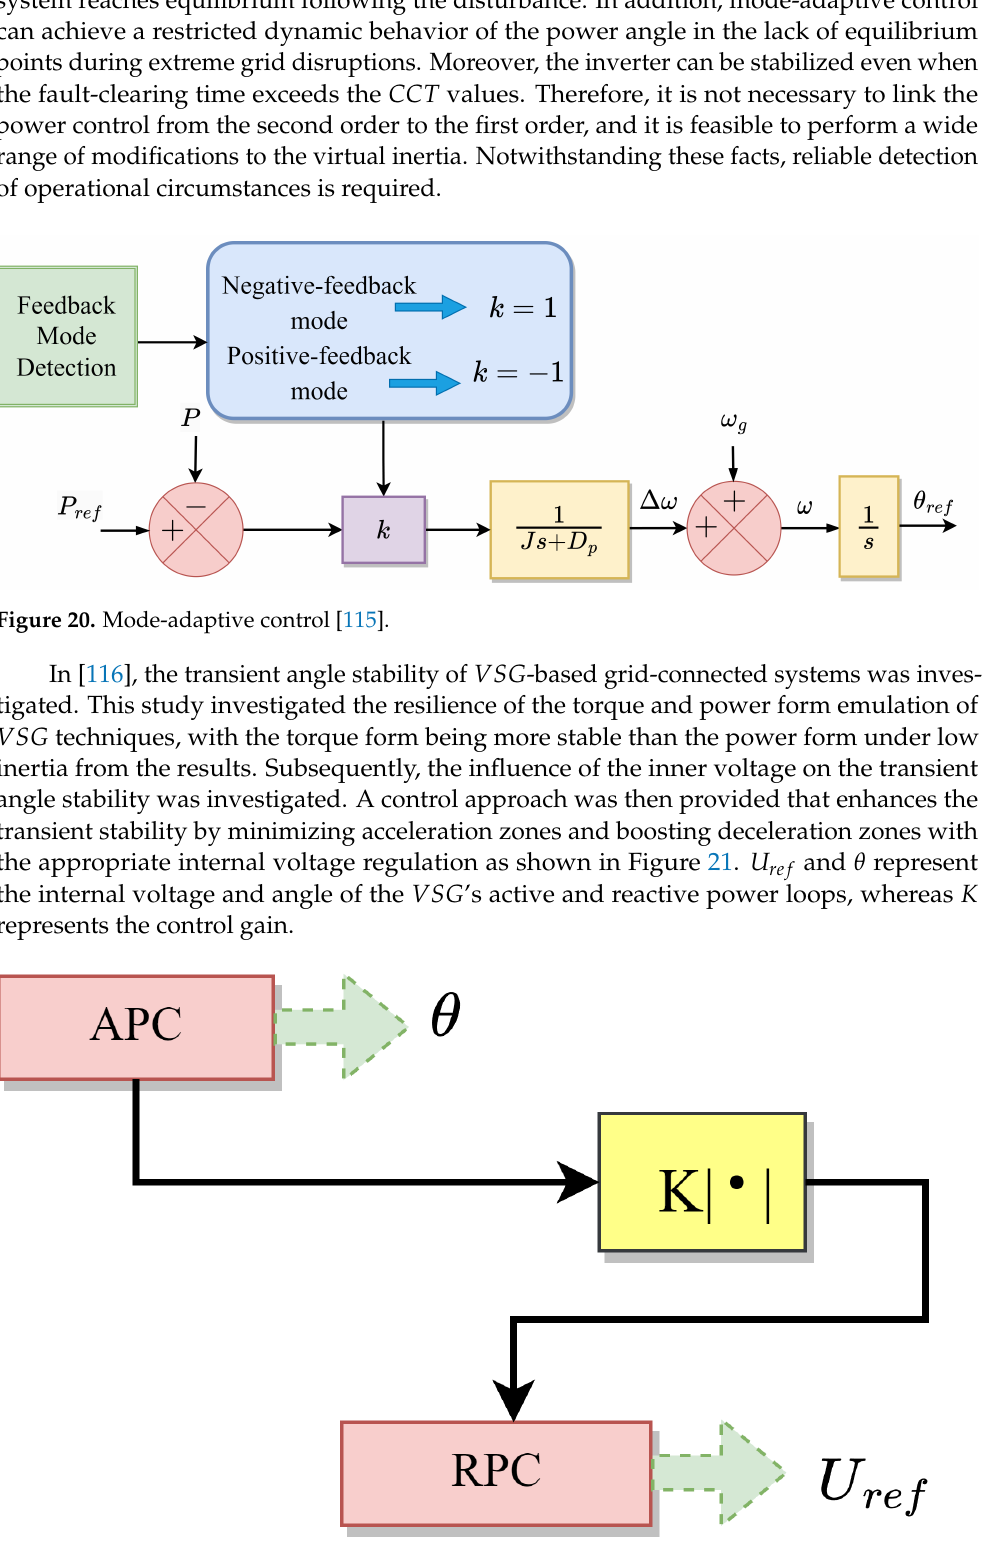
Figure 21. VSG ’s enhanced transient angle stability control approach